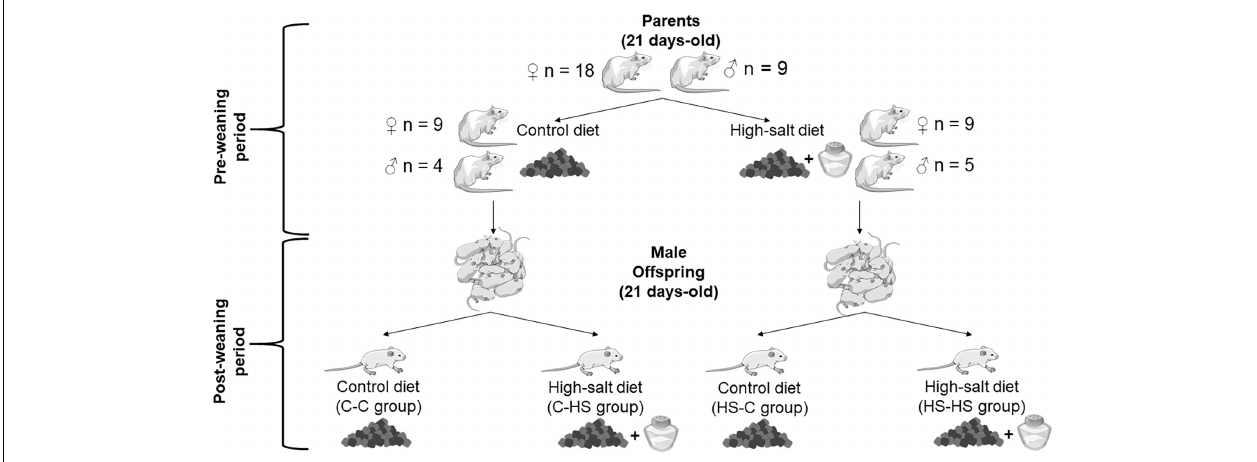
FIGURE 1 | Representation of the experimental design. Control (standard diet; laboratory chow Nuvilab R (cid:13) CR-1) or high-salt (HS) (laboratory chow with added salt 4% NaCl non-iodized) diets were provided for parents at 21 day-old. They received their respective diets for 120 days, until they reached adulthood. During the periods of mating, gestation, and lactation, the dams remained on the aforementioned diets. The preconception, gestation, and lactation periods were classified as “preweaning.” At 21 day-old, the offspring were weaned and received until adulthood the control or HS diets. The period from weaning to adulthood was classified as “postweaning.” Therefore, the offspring were subdivided into the groups: control-control (C-C), offspring of standard diet fed dams who received a standard diet after weaning; control-HS (C-HS), offspring of standard diet fed dams who received a HS diet after weaning; HS-C, offspring of HS diet fed dams who received a standard diet after weaning; and HS-HS, offspring of HS diet fed dams who received a HS diet after